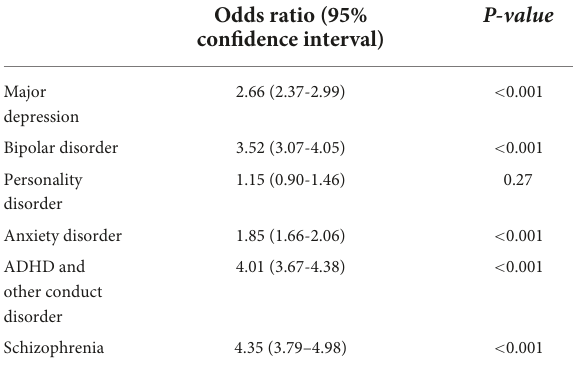
TABLE 2 Multivariable analysis for predictors of homicidal